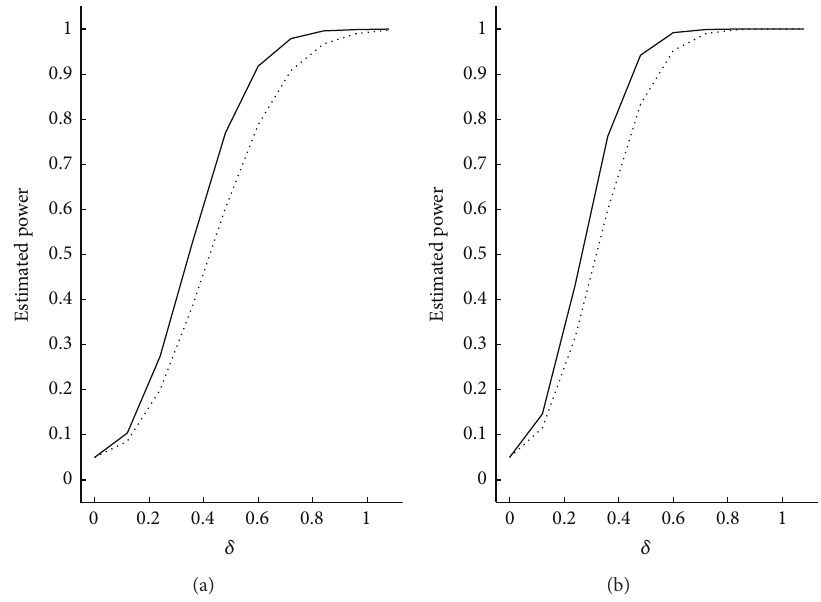
Figure 1: The plot of the estimated power function for sample sizes 𝑛 = 200 and 𝑛 = 300 , where the solid line denotes 𝑛 = 300 and the dotted line denotes 𝑛 = 200 . (a) shows the estimated power function curves with 𝜎 2 𝑢 = 0.4 . (b) shows the estimated power function curves with = 0.25 . 𝜎 2 𝑢